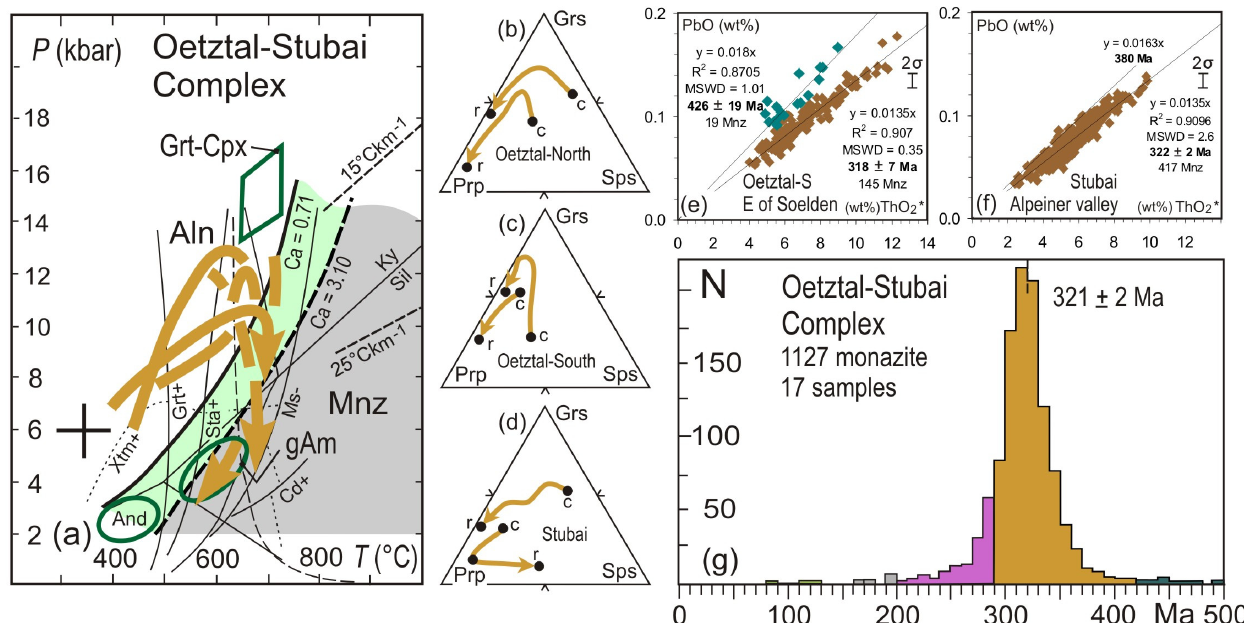
Figure 4. P-T paths, garnet zonations and EPMA Th-U-Pb monazite ages in the Oetztal-Stubai Complex in the Austroalpine Domain. ( a ) P-T paths by microstructurally controlled geothermobarometry from garnet core-to-rim zonations in micaschists and paragneisses in the northern and southern parts of studied area [41,58]. Aluminosilicates (and Ky, Sill), cordierite-in (Cd+), muscovite-out (Ms-) and staurolite-in and -out (Sta+, Sta-) univariant lines [30]. Stability fields (green and gray) of monazite (Mnz) and allanite (Aln) at different bulk rock contents as a function of Ca wt%, and with the xe- notime (Xtm) stability field. Bold cross marks uncertainty of ±50 °C/±1.0 kbar on P-T estimates. Geothermobarometric data from amphibolitised eclogite with garnet-clinopyroxene (Grt-Cpx) and from amphibolite with green amphibole endmember (gAm) equilibria are marked in green ( b – d ) Grossular-pyrope-spessartine (Grs-Prp-Sps) ternary diagrams of garnet core-to-rim (c, r) zonations, colors of arrows are related to the P-T paths in (a). ( e , f ) ThO 2 *-PbO (wt%) isochrone diagrams. The coloured symbols mark analyses belonging to monazite age populations and defining isochrones, falling into Silurian (blue-green) and Carboniferous (brown) ranges of ages. ( g ) Histogram of monazite ages.